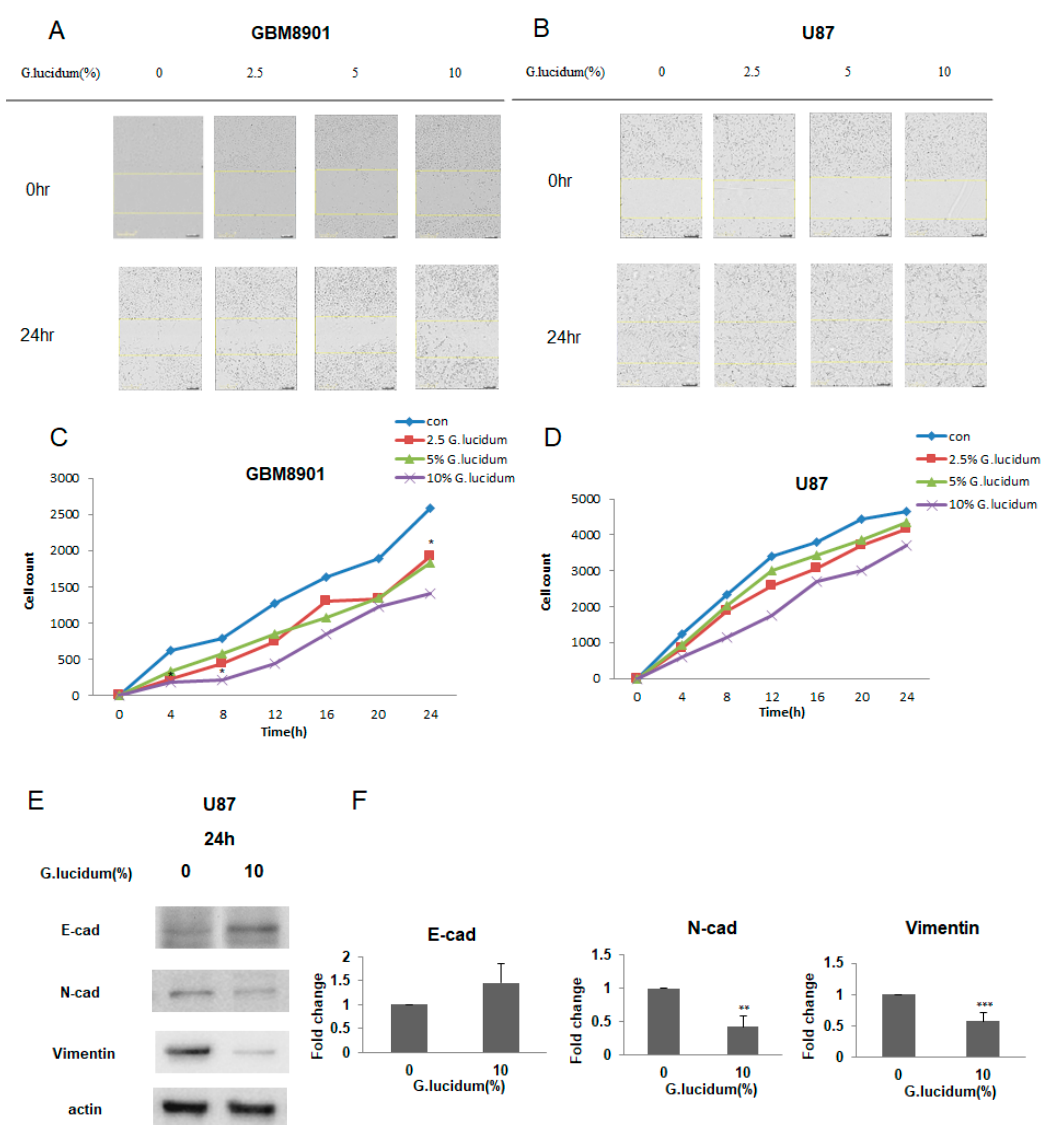
Figure 5. G. lucidum extract inhibits glioblastoma cell migration and inhibits the expression of epithelial–mesenchymal transition (EMT) markers in glioblastoma cells. ( A , B ) Cultures of ( A ) GBM 8901 and ( B ) U87 cells that had undergone wounding were treated with different doses of G. lucidum extract for 24 h. The extent of wound healing was then assessed with the IncuCyte system. ( C , D ) Quantification of ( C ) GBM8901 and ( D ) U87 cells that had migrated into the wound area. U87 glioblastoma cells were treated with or without 10% G. lucidum extract for 24 h. ( A , B ) The cells were then assessed for expression of E-cadherin, N-cadherin, and vimentin ( E ) at the protein level and at the mRNA level by qRT-PCR analysis ( F ) by Western blotting. * p < 0.05; * * p < 0.01; *** p <